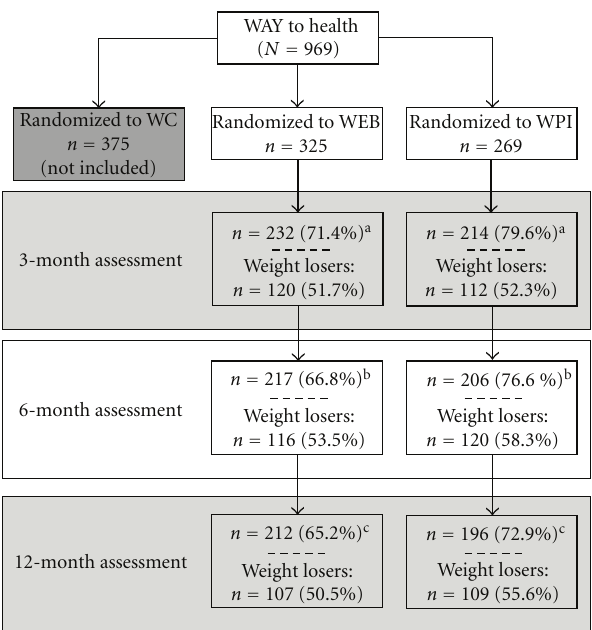
Figure 1: Participant flow diagram. Note. Randomizations num- bers refer the number of cases who were randomized to intervention groups and reminded eligible throughout the study. The top values for each subsequent assessment point represent the number of in- dividuals for whom their objective weight and/or TSRQ values are available. The bottom values report the number of individuals who had lost at least 0.5% of their initial body weight. The lower percentage is the proportion of the returning participants who lost weight during that assessment period. a χ 2 = 4 . 82, df = 1, P = 0 . 03; b χ 2 = 6 . 91, df = 1, P = 0 . 009; c χ 2 = 3 . 99, df = 1, P = 0 .